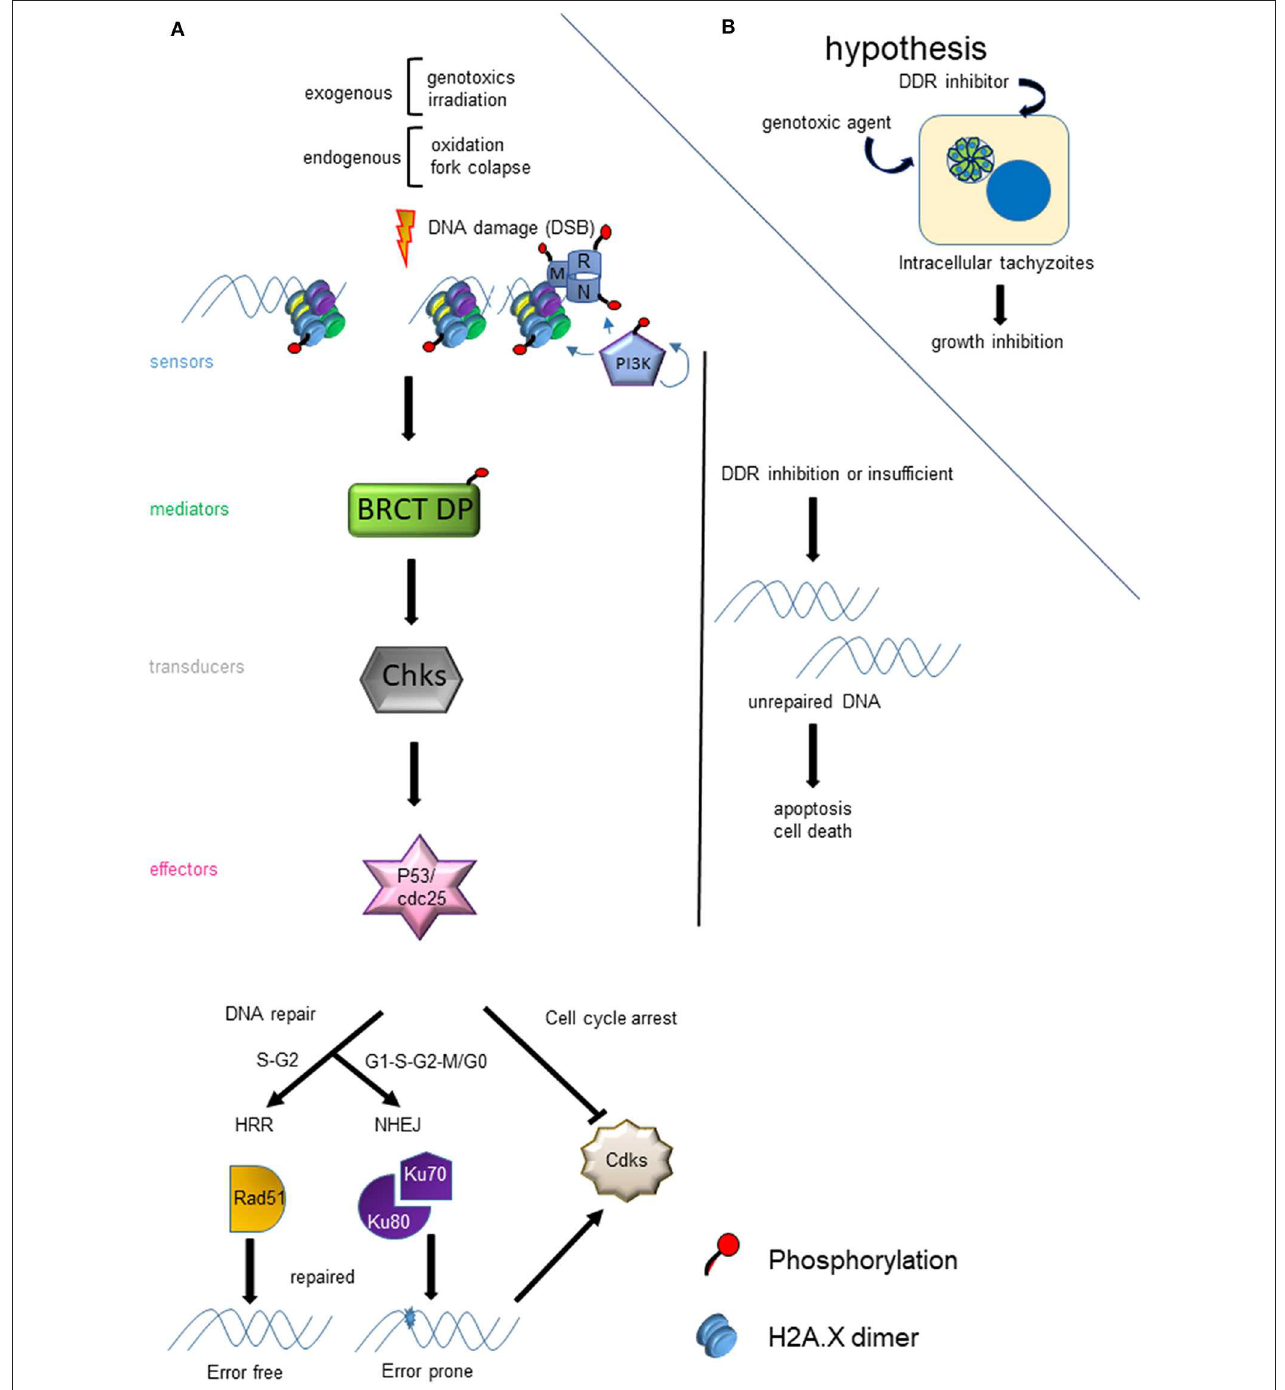
FIGURE 1 | Model of DNA damage response (DDR) due to DSB. (A) The panel shows the cascade of events that are triggered by a DSB and the factors that affect the choice of HRR or NHEJ. (B) The hypothesis of the use of the HRR pathway as a drug target for the development of new anti- T. gondii therapies is graphed.